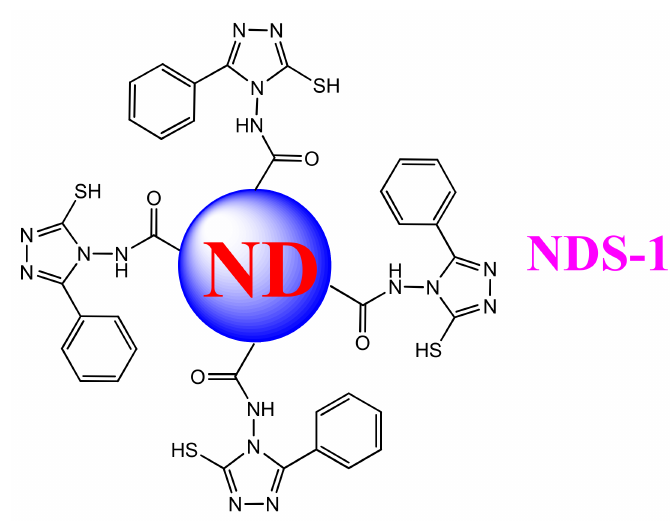
Figure 1. Model structure of NDS1 obtained from pristine nanodiamond (p-ND)